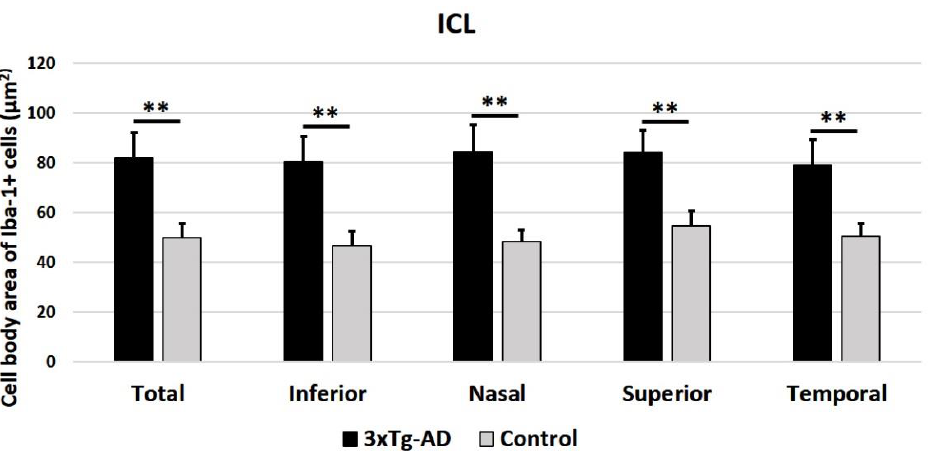
Figure 7. Cell body area of Iba-1 + cells in the inner retinal layer complex (ILC), in 3xTg-AD, and in age-matched control mice in the different retinal zones (inferior, nasal, superior, and temporal), as well as in the total retina. A total of 576 microglial cells were measured for each study group (3xTg-AD and control). Histograms show the mean cell body area (± standard deviation, SD) of Iba-1 + cells. Statistically significance indicators: ** p < 0.01.